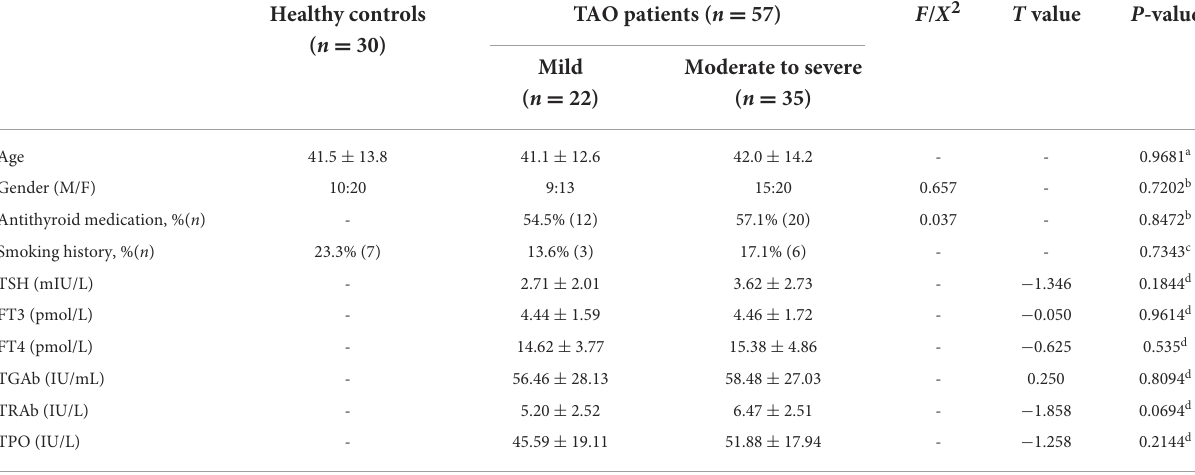
TABLE 1 Demographics of the healthy controls and thyroid-associated orbitopathy (TAO) patients.